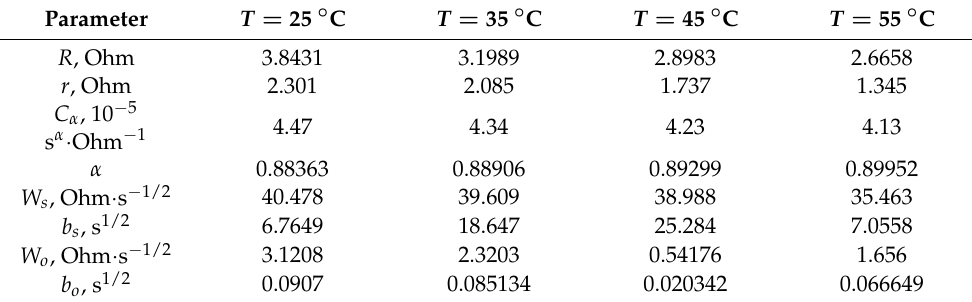
Table 2. Equivalent circuit model parameters for different